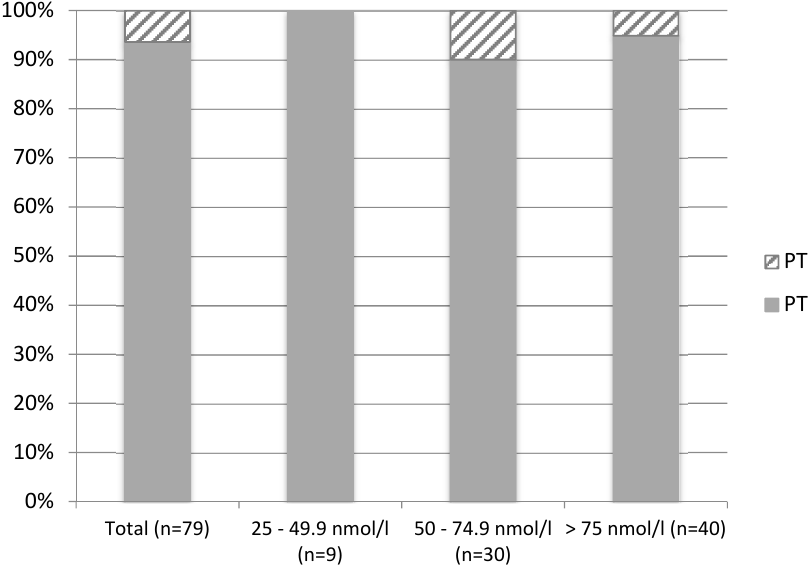
Figure 3. Prevalence of secondary hyperparathyroidism (PTH > 6.9 pmol / L) according to vitamin D status in Brazilian women living in Brazil ( n = 79). Table 8. Associations between PTH concentrations and radial bone densitometry assessed by pQCT of Brazilian women living in England ( n = 51) 1 .